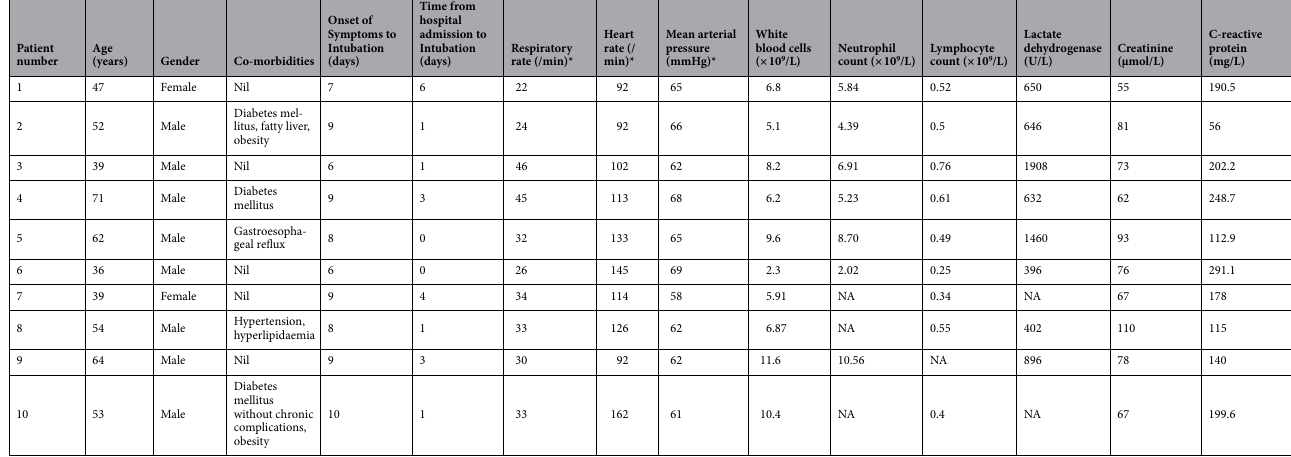
(Table 2, Fig. 1). A full multivariate model including both as continuous variables generated an AUROC of 0.928 (95% CI 0.828–0.979, p < 0.0001) (Fig. 1A). A simplified model using the categorical variables neutrophil count > 4 × 10 9 /L and respiratory rate > 18 breaths per minute had an AUROC of 0.889 (95% CI 0.779–0.956,